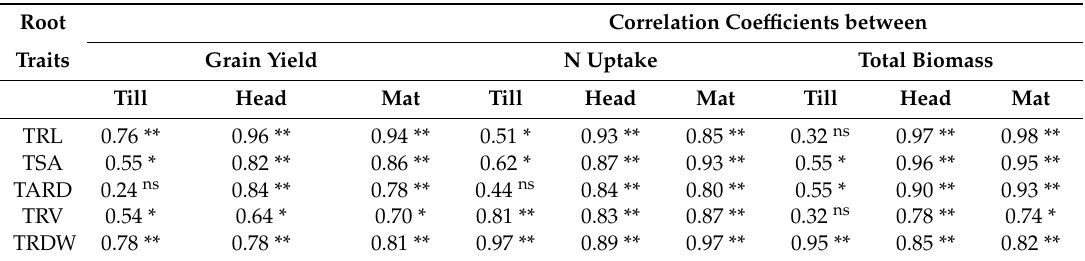
Table 8. Correlation coe ffi cients of yield, N uptake, and biomass accumulation with root morphological features at di ff erent growth stages under organic and inorganic fertilizer application.